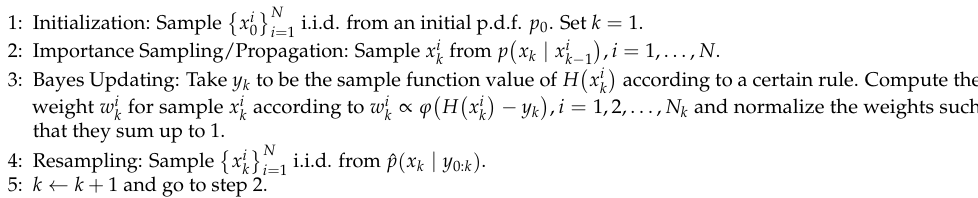
Algorithm 2 General particle filter optimization